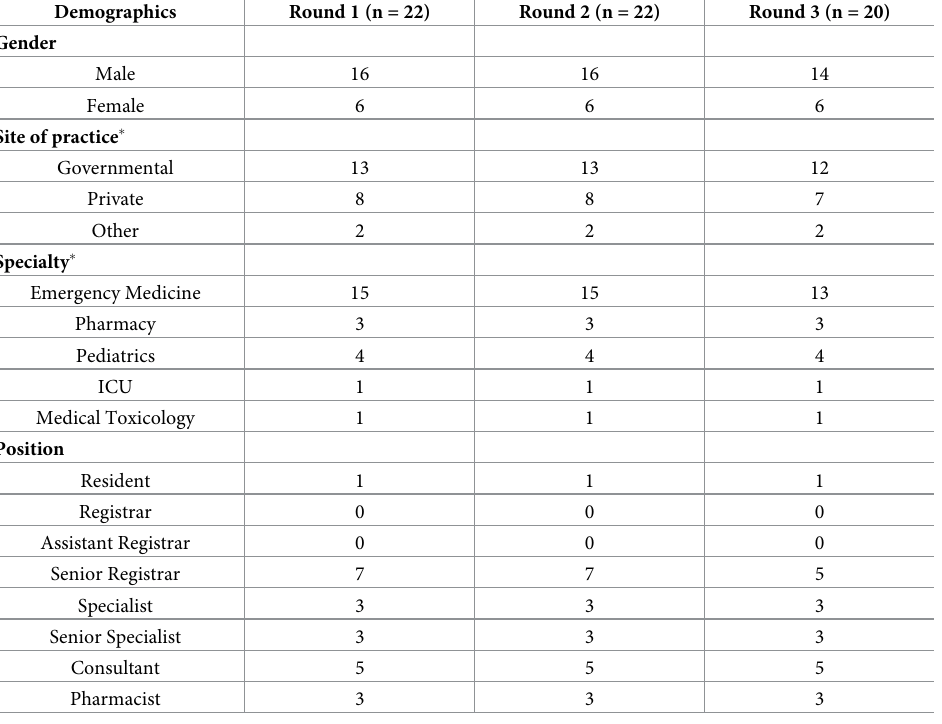
Table 1. Demographics of experts in Rounds 1, 2 and